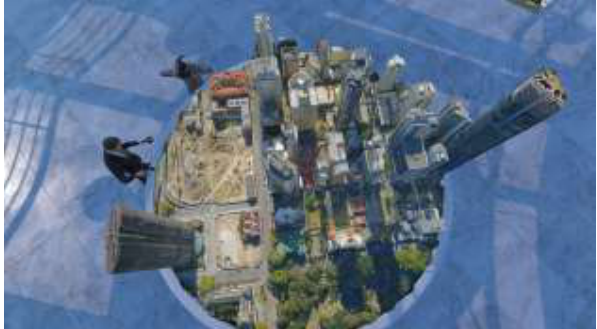
Figure 10: Find the best point of view for a certain object in